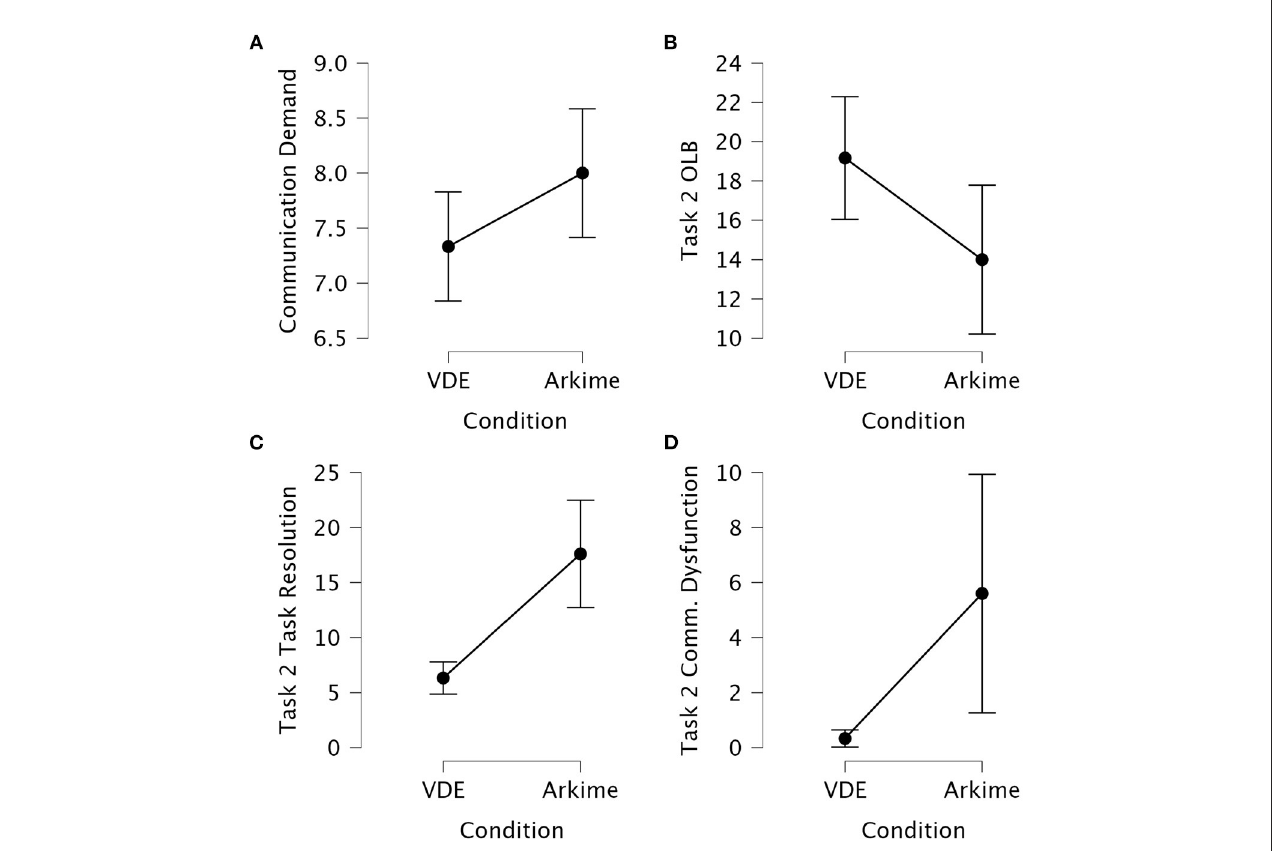
FIGURE7 Interval plots for between-group differences in self-reported and observed communication variables. (A) Self-reported communication demands after part two of the experiment. (B) Observed task two OLB communication. (C) Observed task two task resolution communication. (D) Observed task two communication dysfunction. Whiskers are 95% confidence